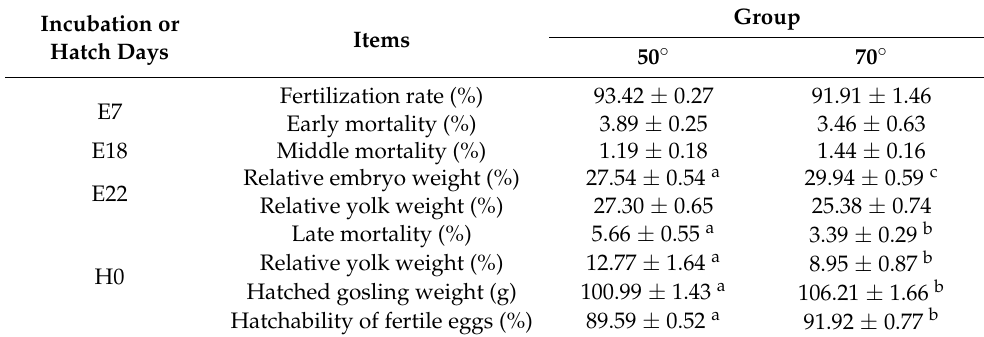
Table 2. Hatching performance, relative yolk, and embryo weight at 70 ◦ and 50 ◦ turning angles.